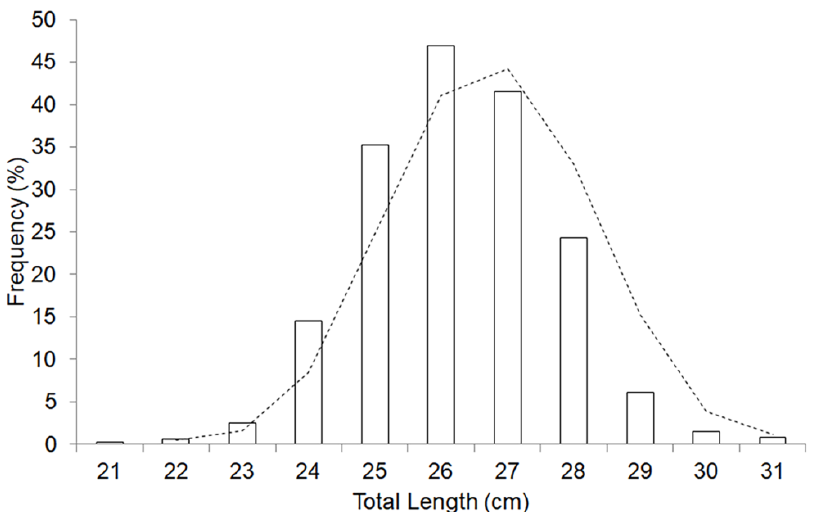
Figure 3. Size frequency distributions for Sardina pilchardus caught off the Northern Senegalese waters. The total length was used (in cm); mode at 26 cm (n = 3951). The observed distribution (bars) and a trend curve (polynomial).